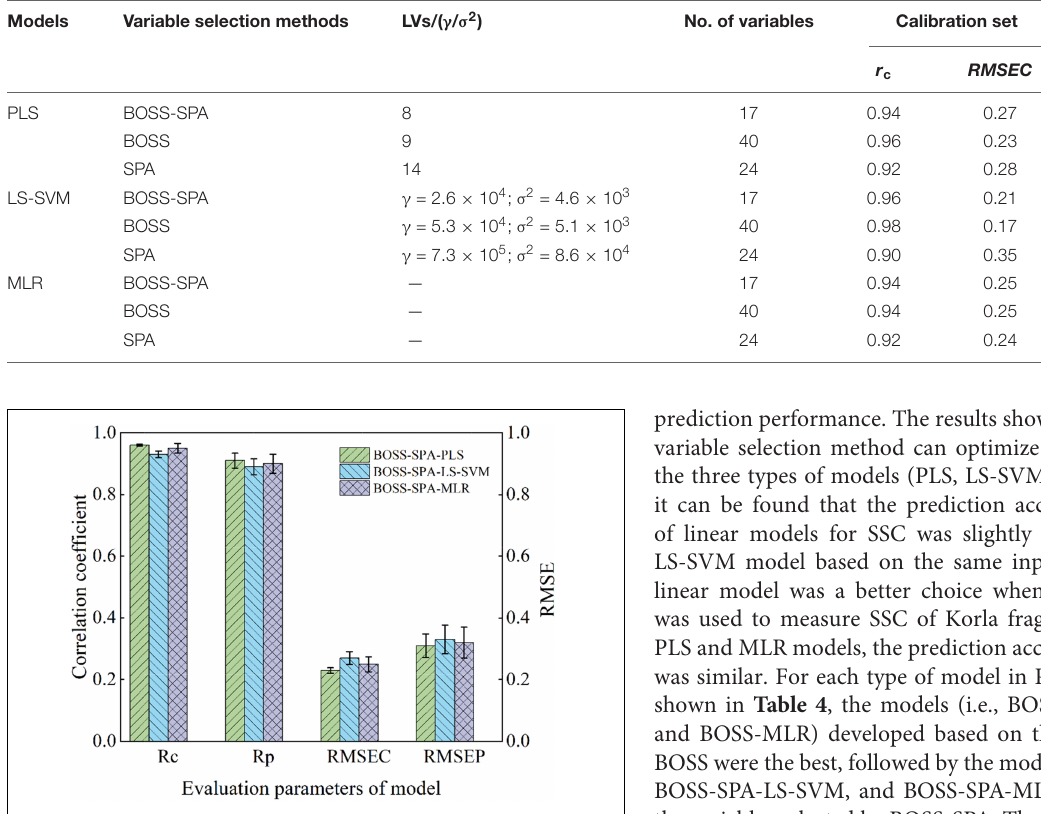
Frontiers in Plant Science |